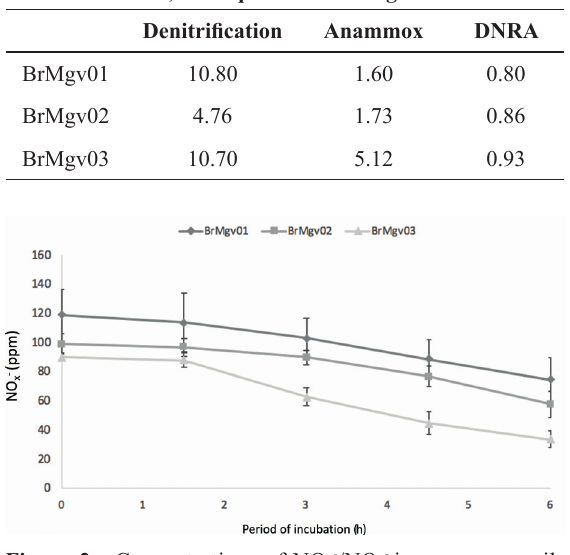
Figure 2 - Concentrations of NO 3- /NO 2- in mangrove soils along the isotopic experiment. Values represent average values of three replications and bars reveal the standard error of the